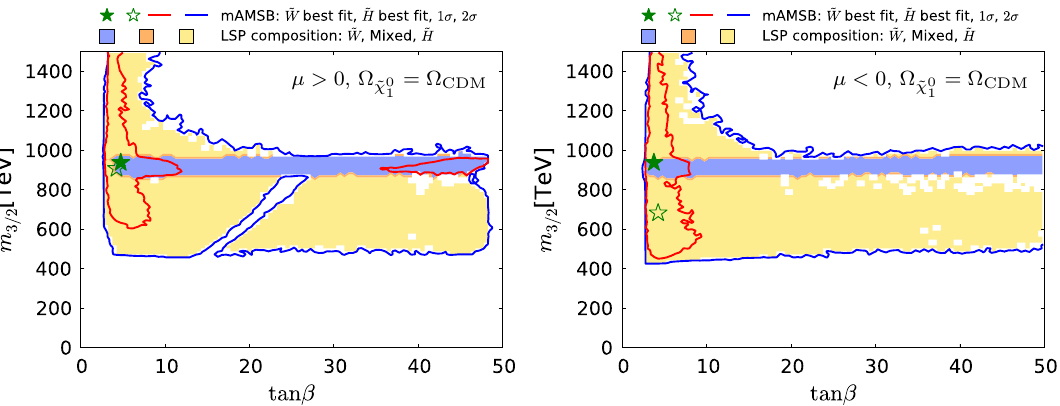
Fig. 7 The ( tan β, m 3 / 2 ) planes for μ > 0 ( left panel ) and μ < 0 ( right panel ), assuming that the ˜ χ 0 and colouring convention for the contours are the same as in Fig. 4, and the best-fit points for the two signs of μ are again indicated by green